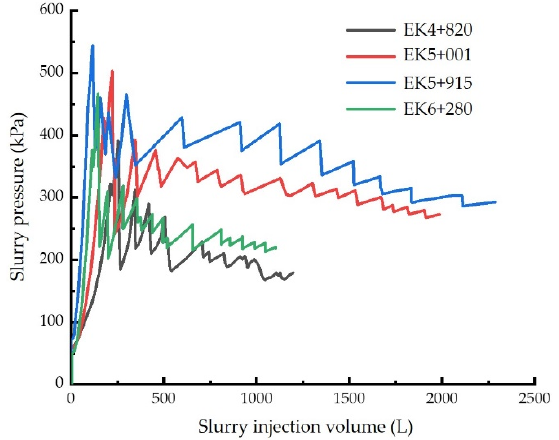
Figure 18. Variation of slurry pressure with slurry injection volume at different sections.